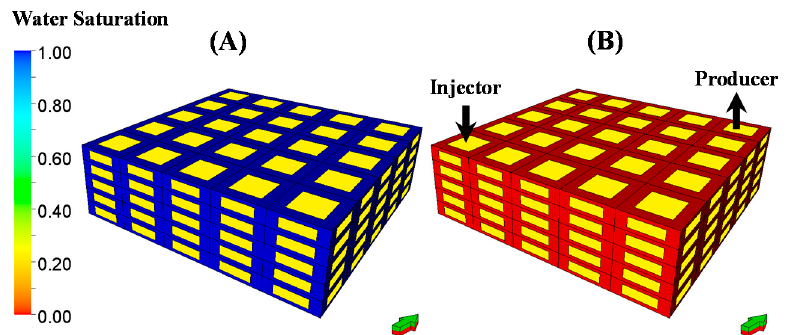
Figure 5. The simulated cases of the intermediate scale model, ( A ) fractures were saturated entirely with oil, and the model comprises a low salinity brine injector, and an oil producer ( B ) fractures were filled with water, and the fluid exchange occurred due to capillary, viscous, and gravity